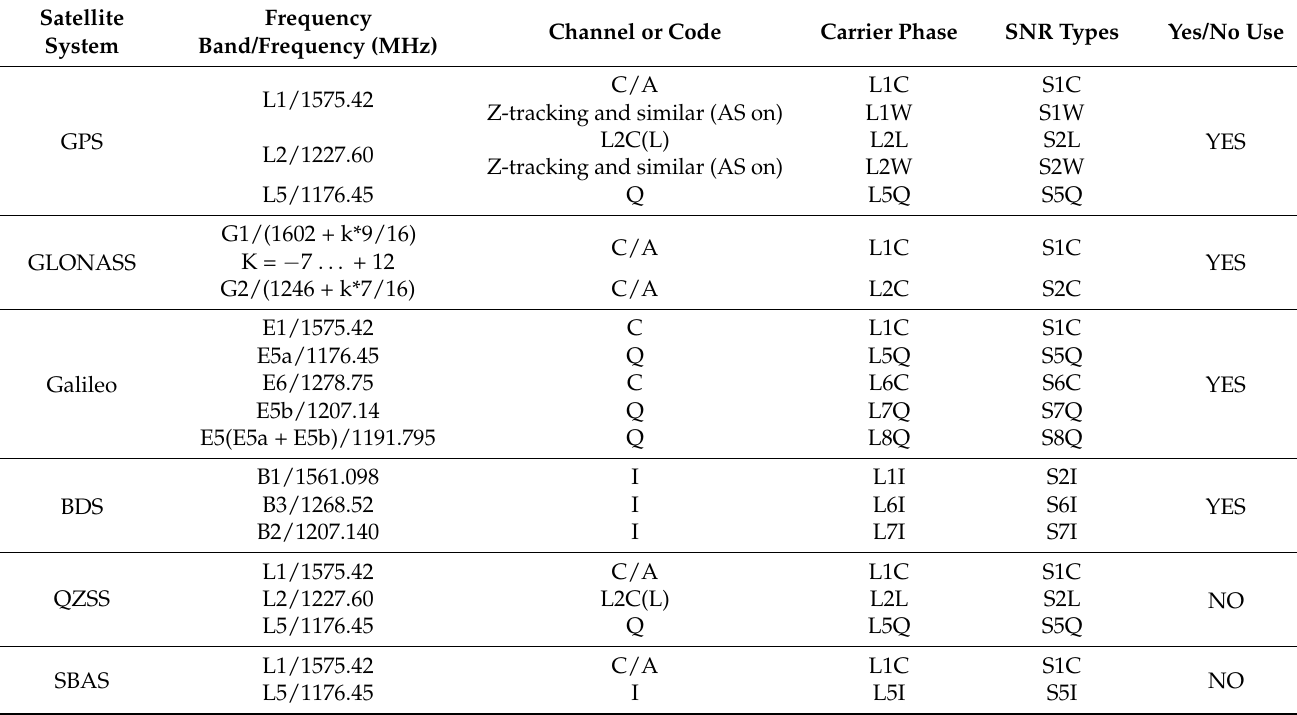
Table 1. Multi-GNSS and multi-frequency SNR types and description information provided by the P387 station.